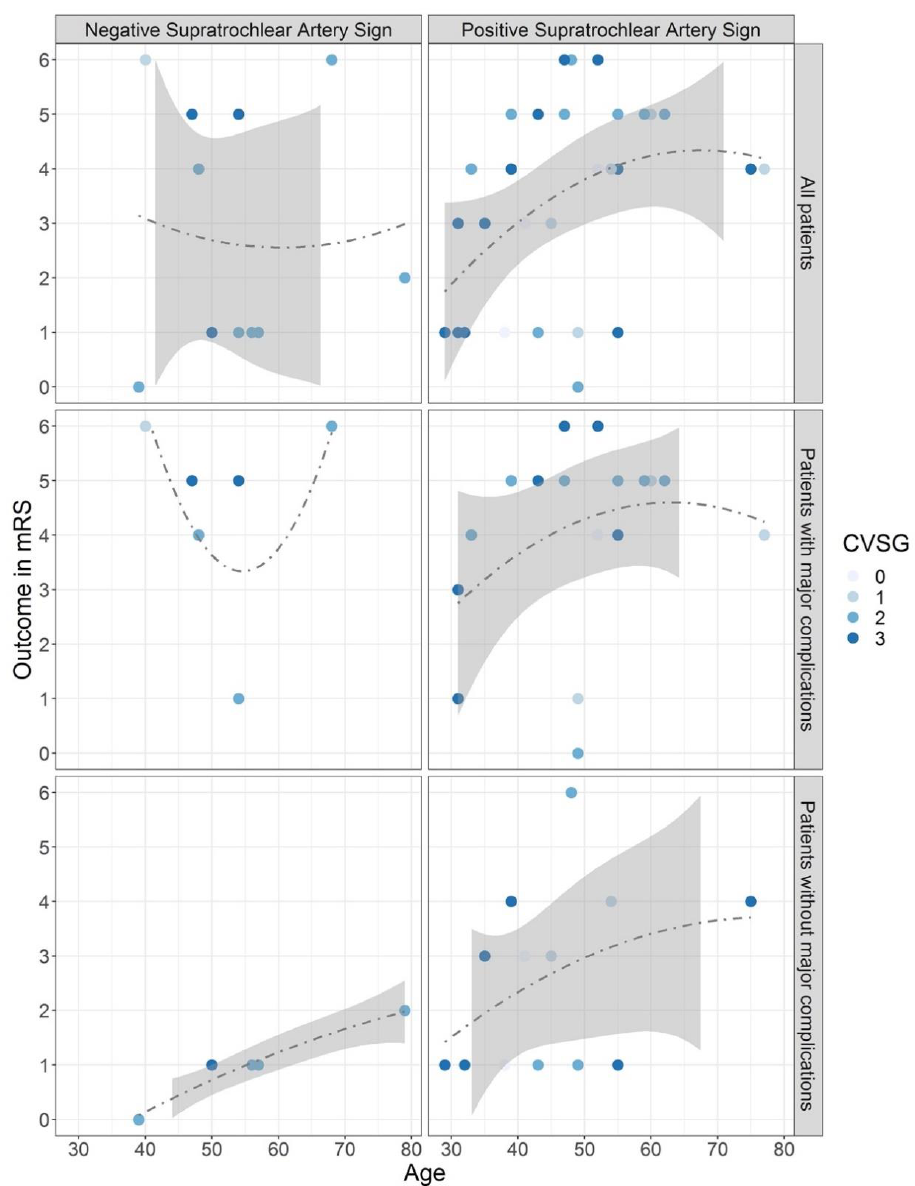
Figure 3. Supratrochlear artery sign with polynomial regression. The diagrams of the first line include all patients ( n = 43). The graphs of the second line select patients suffering from major complications ( n = 24) like intracerebral hemorrhage, systemic inflammatory response syndrome, sepsis, pneumonia, or renal failure, that worsened the functional outcome. The graphs of the third line depict patients without major complications ( n = 19). The left and right columns show the rating for the negative and positive supratrochlear artery (STA) sign, respectively, according to patient’s age, outcome in modified Rankin Scale (mRS) score, cerebral vasospasm grade (CVSG) at the time-point of positive STA sign or highest CVSG for negative STA sign. The gray area displays the 95% confidence interval. Please note that the colored area is missing if it was out of the outcome range. The polynomial regression lines are graphed in grey. There is a significant correlation between unfavorable outcomes for positive supratrochlear artery signs with advancing age. The outcome is even aggravated with major complications (intracranial hemorrhage and/or severe co-morbidities). DNA and AFA signs did not prove to be meaningful predictors (not shown).